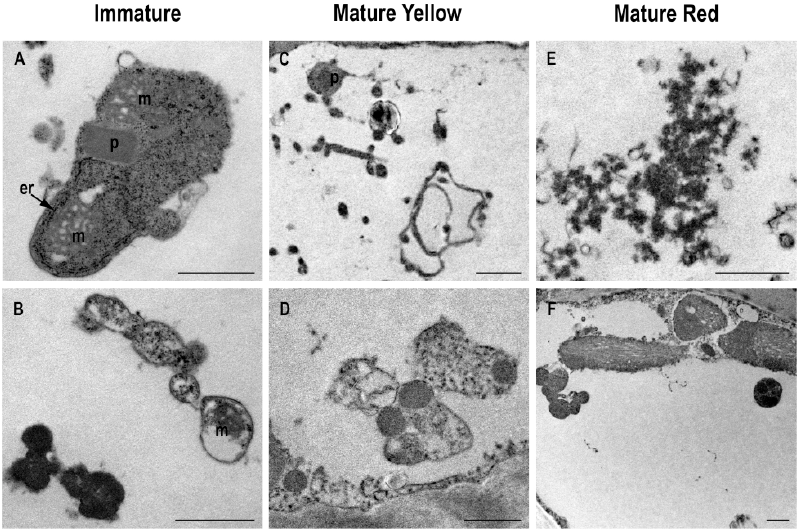
Figure 8. Electron micrographs of green Galena ( A , B ), yellow Galena ( C , D ) and red Alonso ( E , F ) pepper fruits. p = peroxisome, m = mitochondria, er = endoplasmatic reticulum. Scale bar = 1 µm.